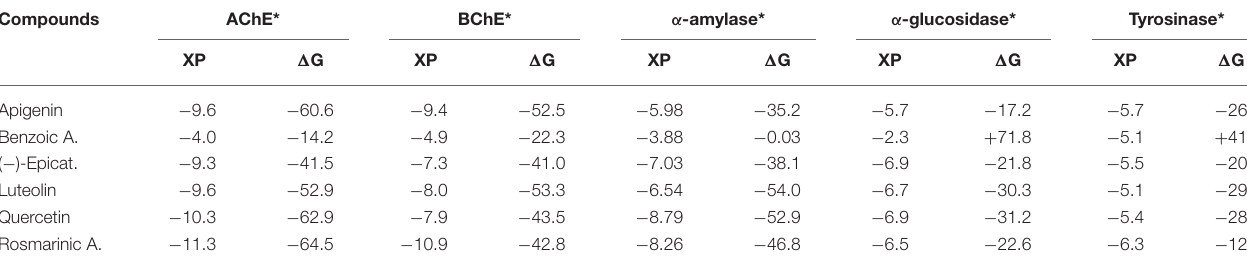
TABLE 1 | Binding energy and glide XP docking